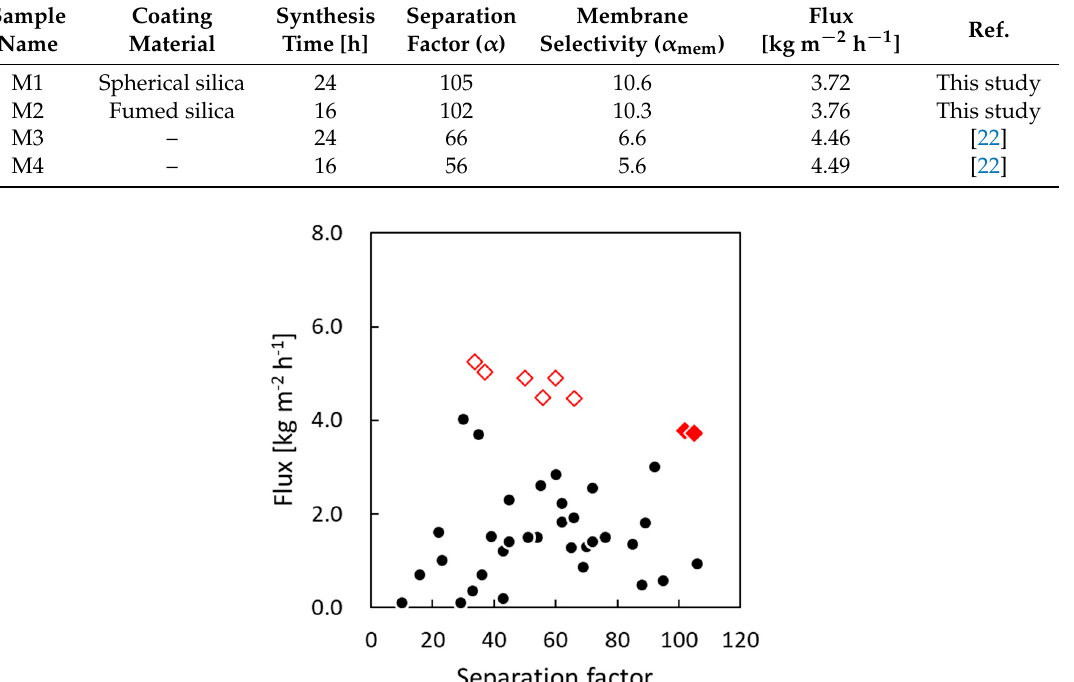
: gel-free SAC (cid:51)